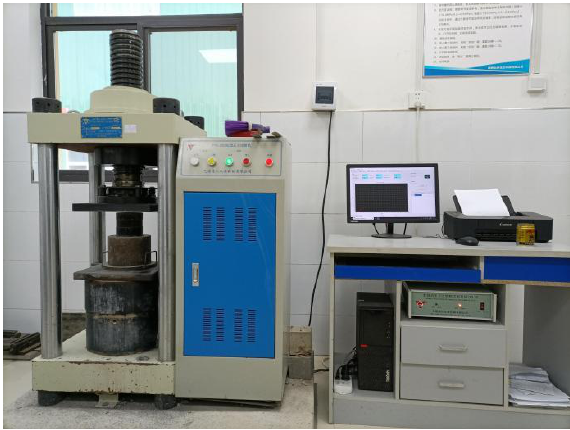
Figure 6. Pressure-testing machine.